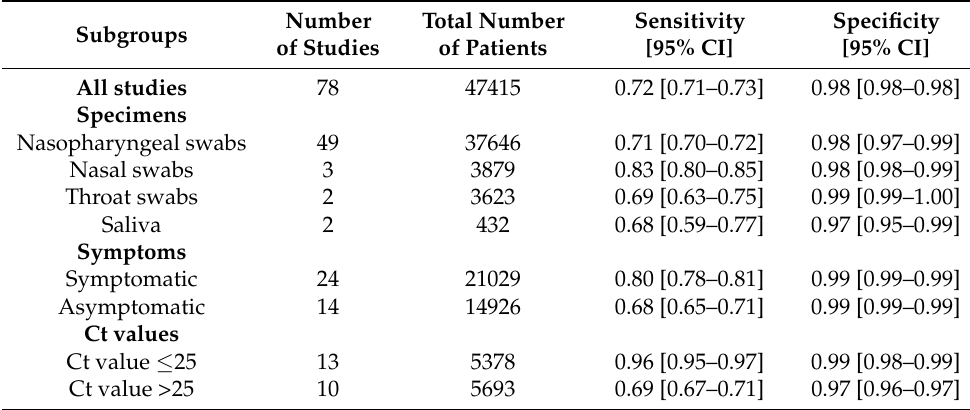
Table 4. Summary of subgroups analysis excluding case–control studies.